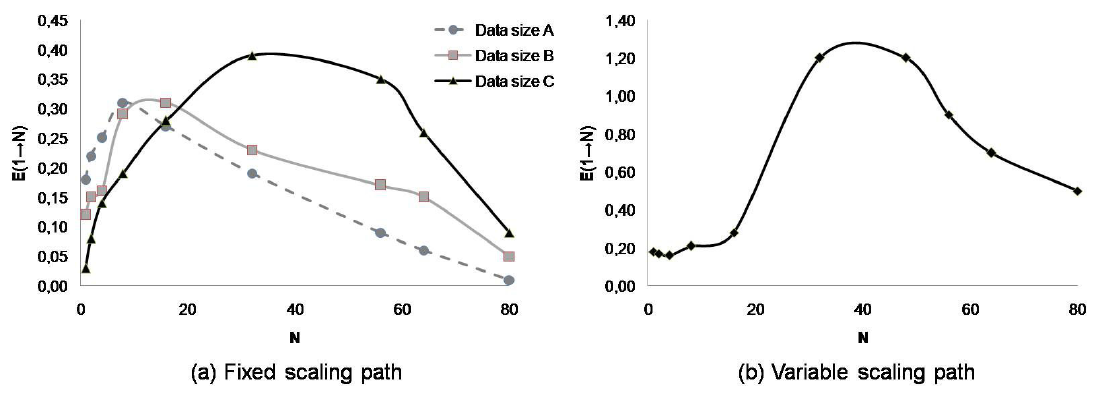
Figure 3: Fluid physics simulation service elasticity analysis with the two considered scaling